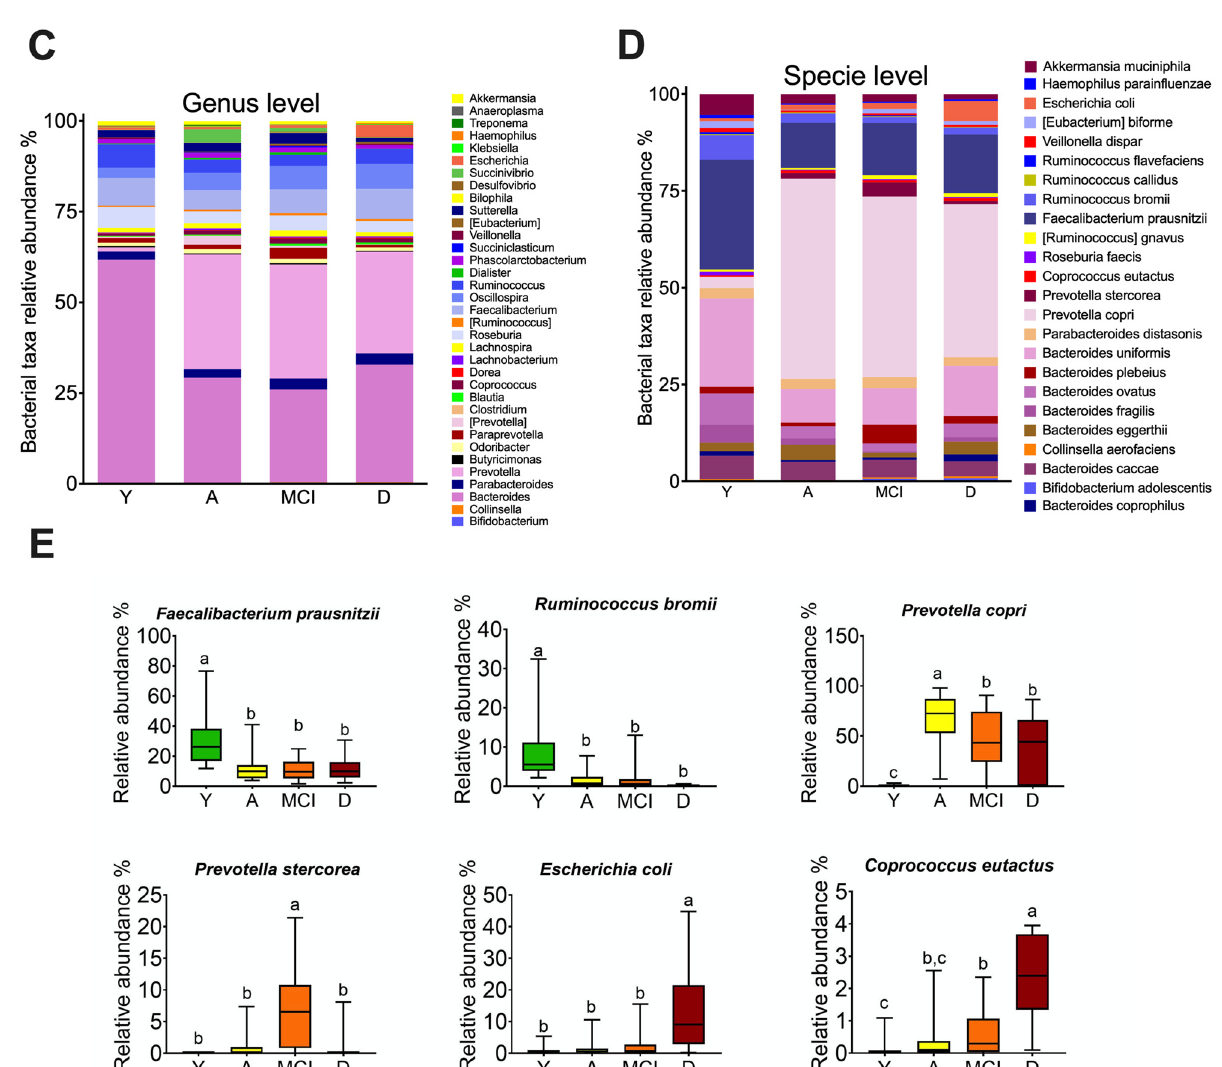
Figure 2. Changes in the gut microbiota profile associated with mild cognitive impairment and dementia in humans. Shannon index ( A ). Relative abundance of the intestinal microbiota at the level of phylum ( B ), genus ( C ), and species ( D ). Operational taxonomic units at the species level with significant changes among all groups ( E ). Y = young, A = aging, MCI = mild cognitive impairment, D = dementia, a > b > c > d, significance p < 0.05.